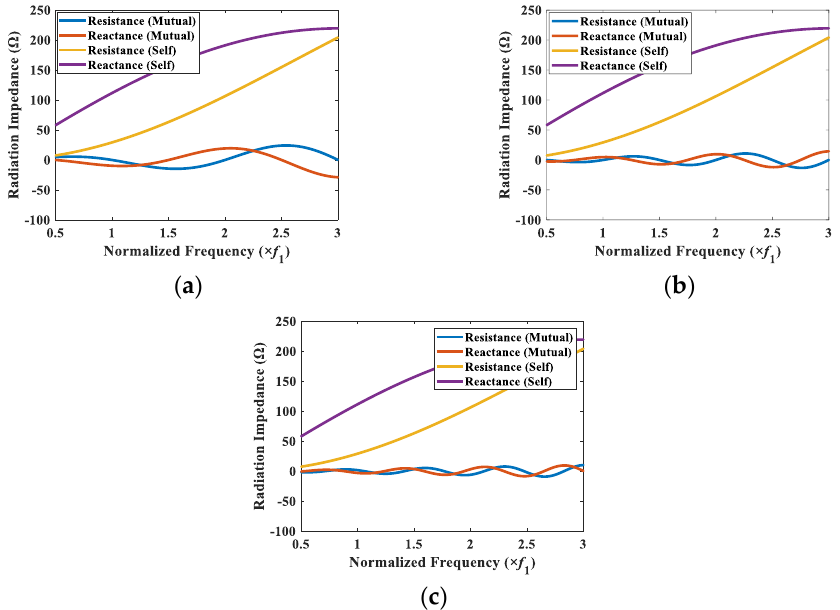
Figure 8. TVR spectra of a cymbal transducer with mutual radiation impedance added to the radiation load for different CTC spacings from its adjacent cymbal transducer.